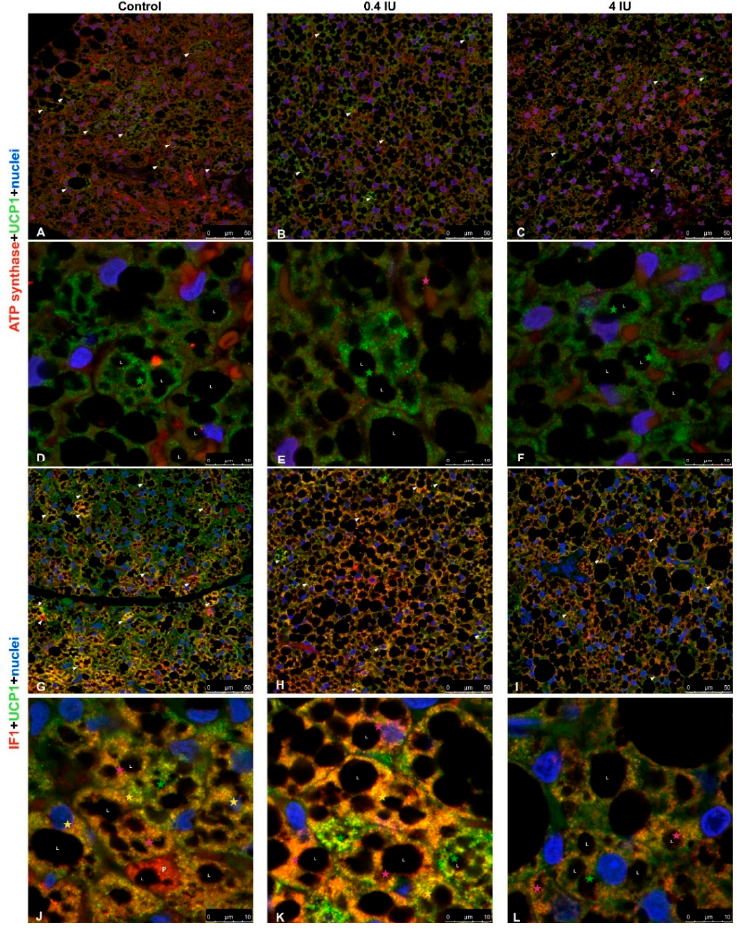
Figure 11. Immunofluorescence of UCP1/ATP synthase and UCP1/IF1 in BAT following acute insulin treatment. ( A – F ) Double labeling with antibodies against UCP1 (green) and ATP synthase (red). ( G – L ) Double labeling with antibodies against UCP1 (green) and IF1 (red). Harlequin effect is shown with arrowheads. BAT showed various brown adipocytes with different degrees of immunoexpression: UCP1-only brown adipocytes (light-blue star); UCP1 predominantly positive brown adipocytes (green star); brown adipocytes with clear colocalization of UCP1 and ATP synthase/IF1 (yellow star); ATP synthase/IF1 predominantly positive brown adipocytes (pink star); and ATP synthase/IF1-only brown adipocytes (red star). L—lipid body; P—preadipocyte. Nuclei were stained with Sytox Orange. ( A – C ) and ( G – I ), scale bar = 50 µm. ( D – F ) and ( J – L ), scale bar = 10 µm.